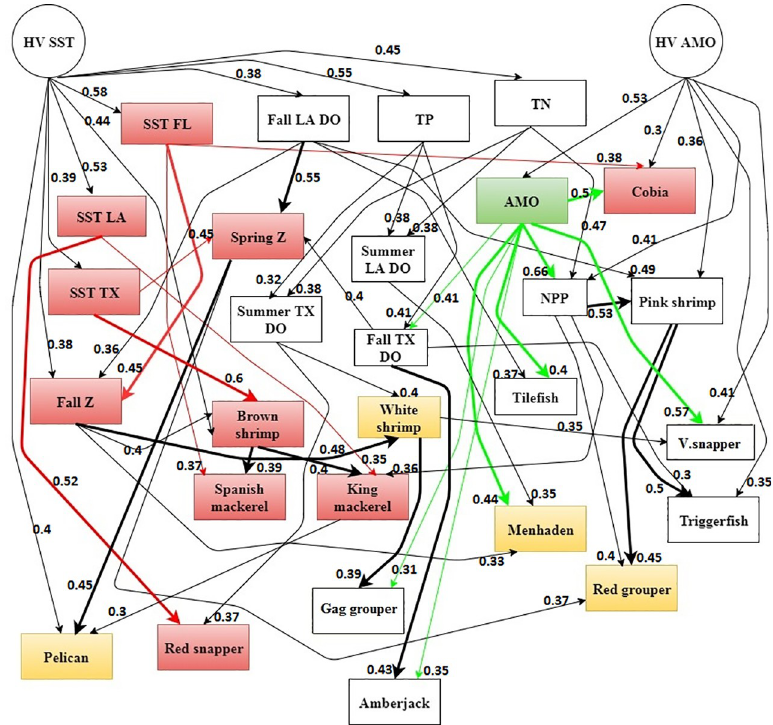
Fig 3. Dependency relationships. The dependency relationships between all the measured ecosystem components and two unmeasured hidden variables (HV AMO and HV SST), learned from the hill- climb, and which were used to construct the DDDBN model. Only the bold links (regardless of color) were used to build the ARDBN. Colors were used to assist visualization of the network. Red colored nodes and arrows denote direct influence by SST. Nodes highlighted in yellow are indirectly influenced by SST. Green colored node and arrows denote direct influence by AMO. The strength of each identified link (i.e. the level of confidence) is also reported.